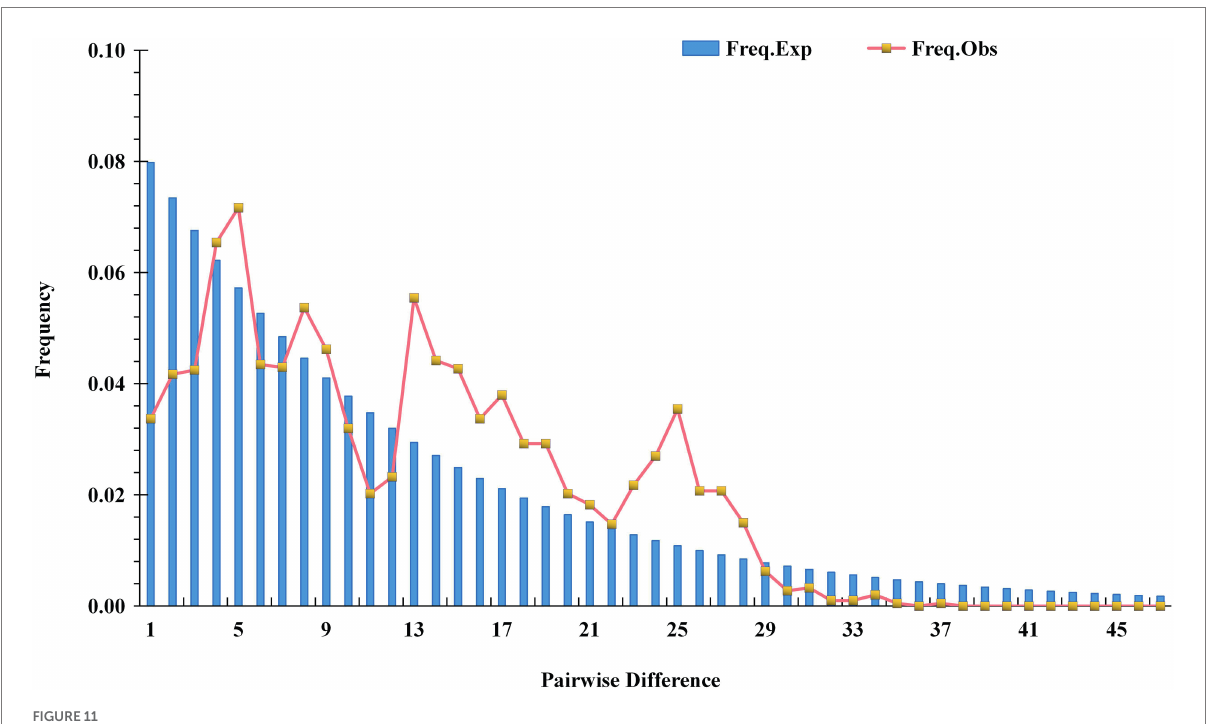
FIGURE 11 Mismatch distribution plots for the test